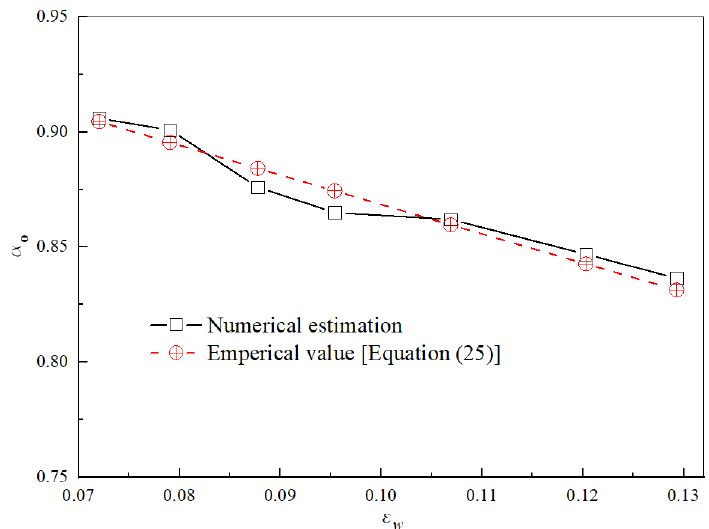
Figure 2. Comparison of numerical and empirical results.